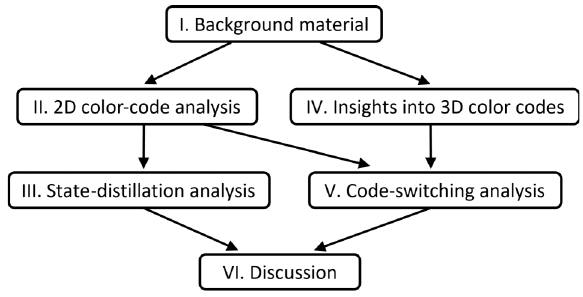
FIG. 3. Flow diagram illustrating the organization and depen- dencies between different sections of the